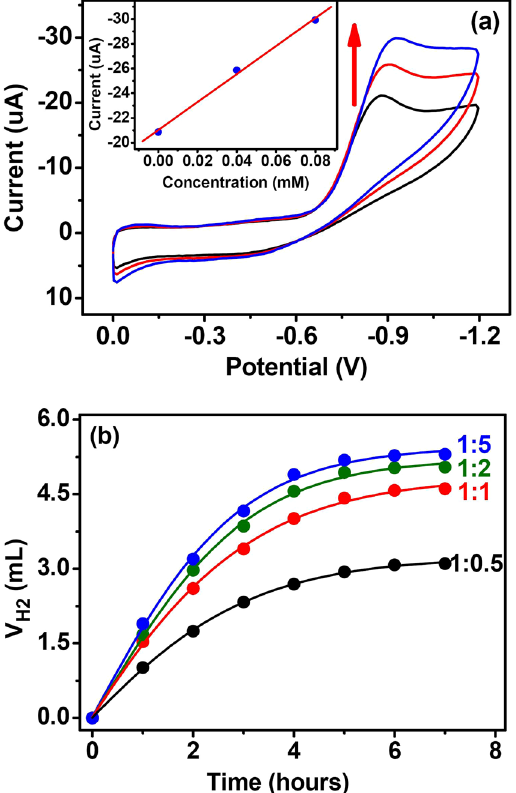
Figure 3. ( a ) Cyclic voltammograms of Co– ZPB (0.1 mM) containing n -Bu 4 NClO 4 (0.1 M) in a CH 3 CN solution and upon the addition of Et 3 NHCl with concentrations of 0.04 mM (red line) and 0.08 mM (blue line), respectively. Scan Rate: 100 mV/s. The inset showing the i c vs . [HNEt 3 ]. ( b ) H 2 production after irradiation of the system containing TEA (5%), Co– ZPB (0.1 mM) and different concentrations of Fl